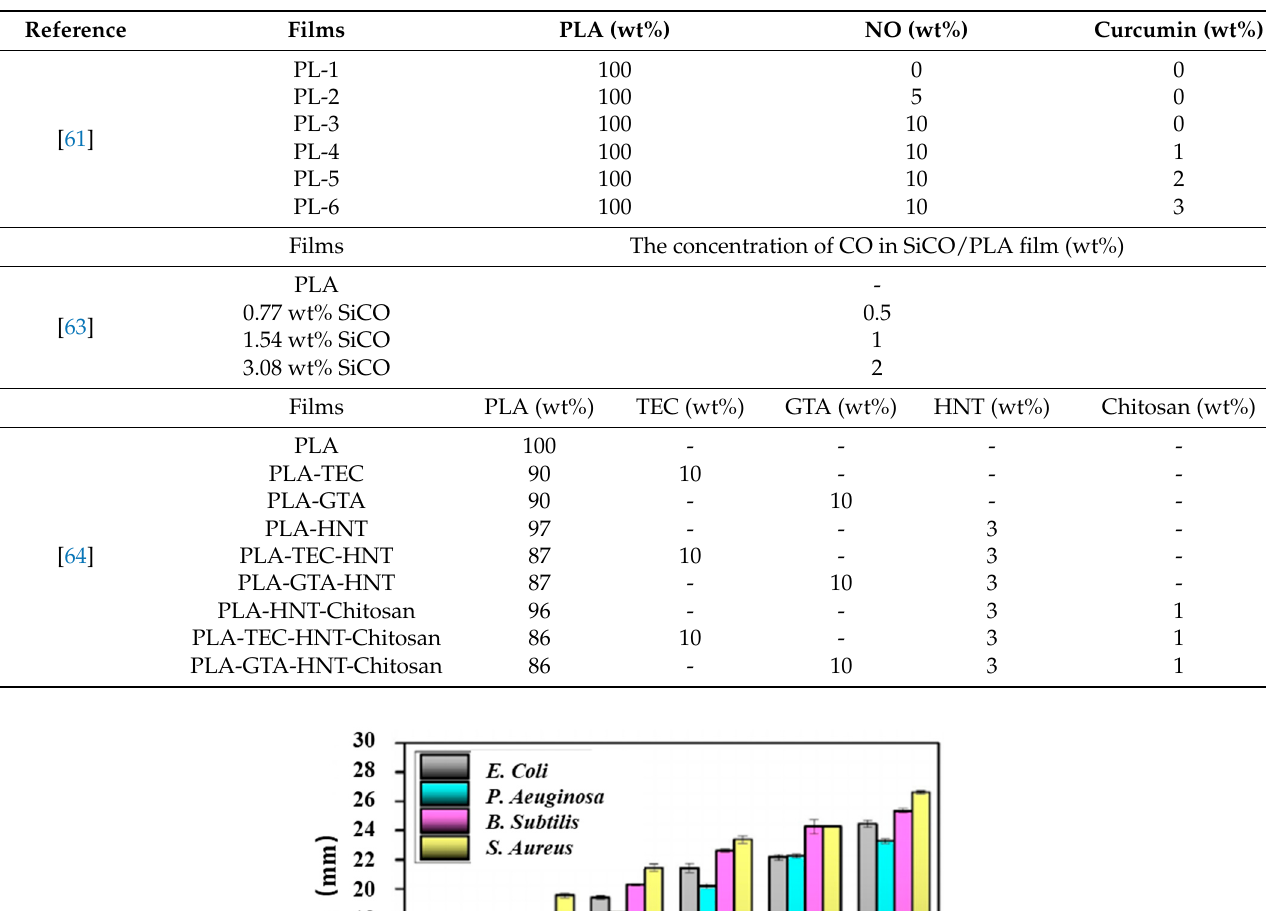
Table 5. Names of samples in the literature.